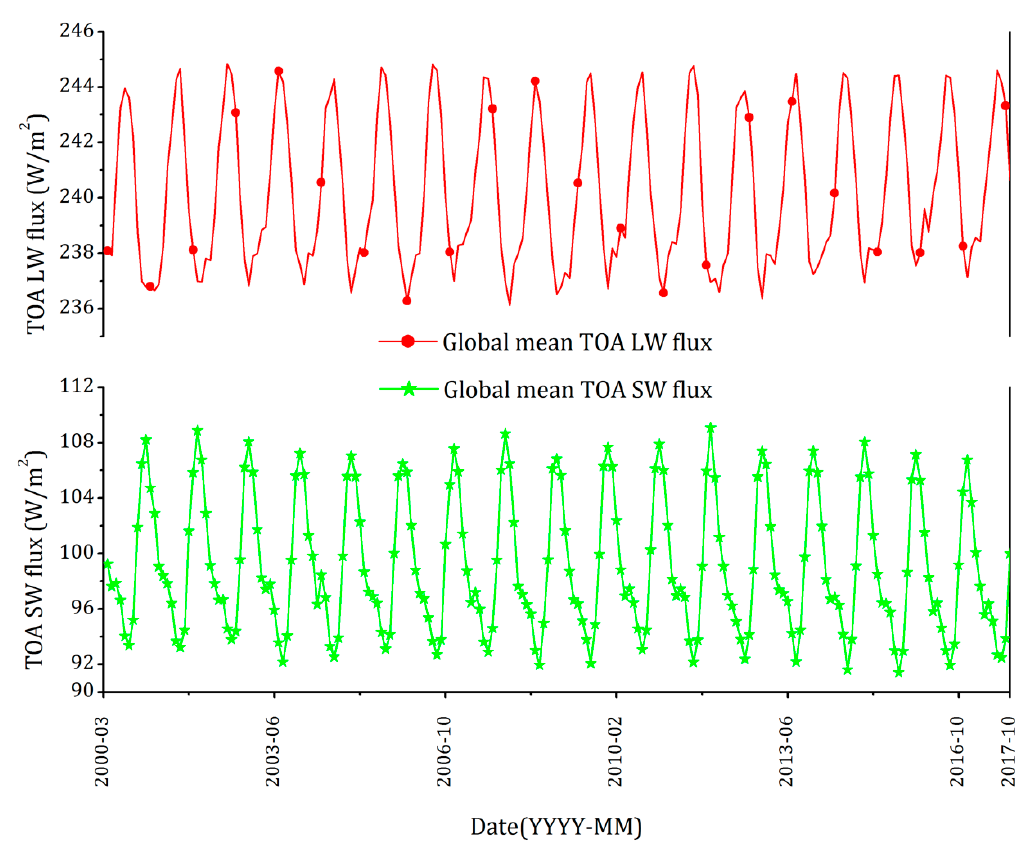
Figure 9. Global mean Earth TOA SW and LW fluxes from March 2000 to October 2017 derived from the CERES EBAF dataset.